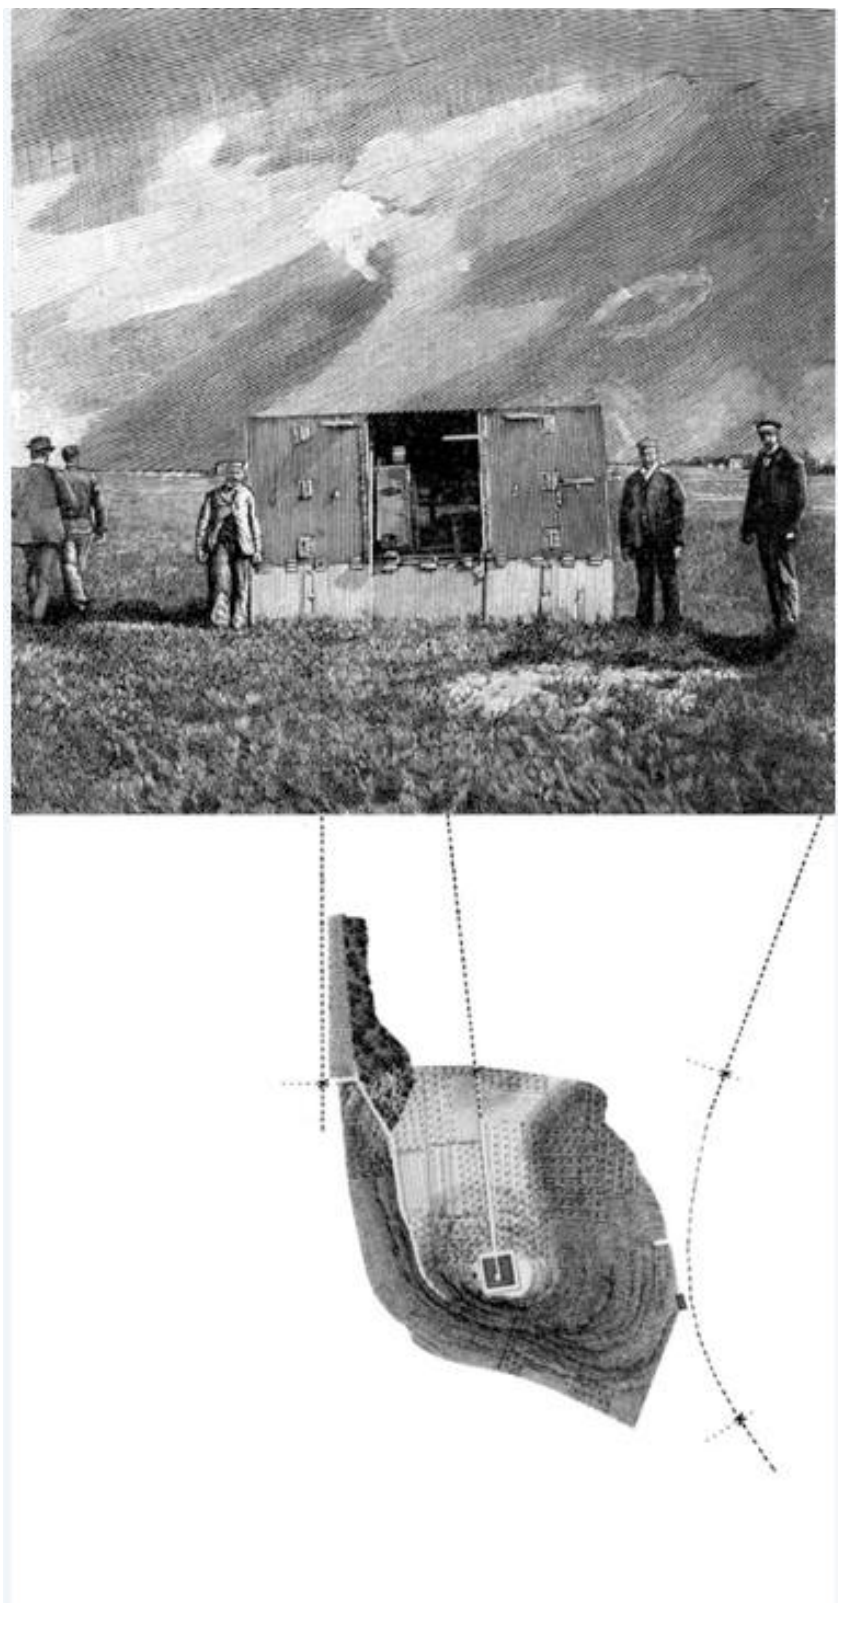
Figure 8. Paper Collage comprised of original engravings from La Grande Illustré (1904); a commonplace elevation pours out absence